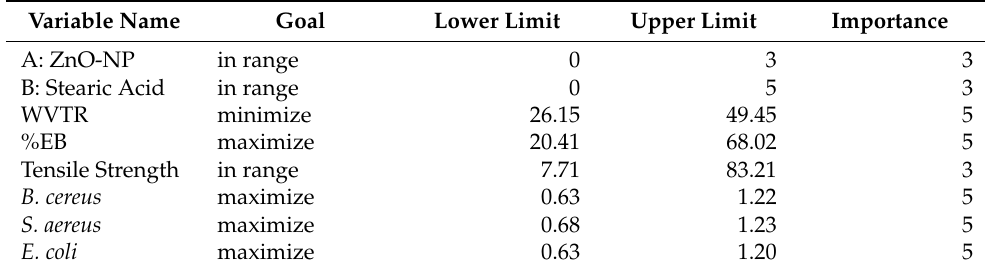
Table 3. Constraints for the optimization process.